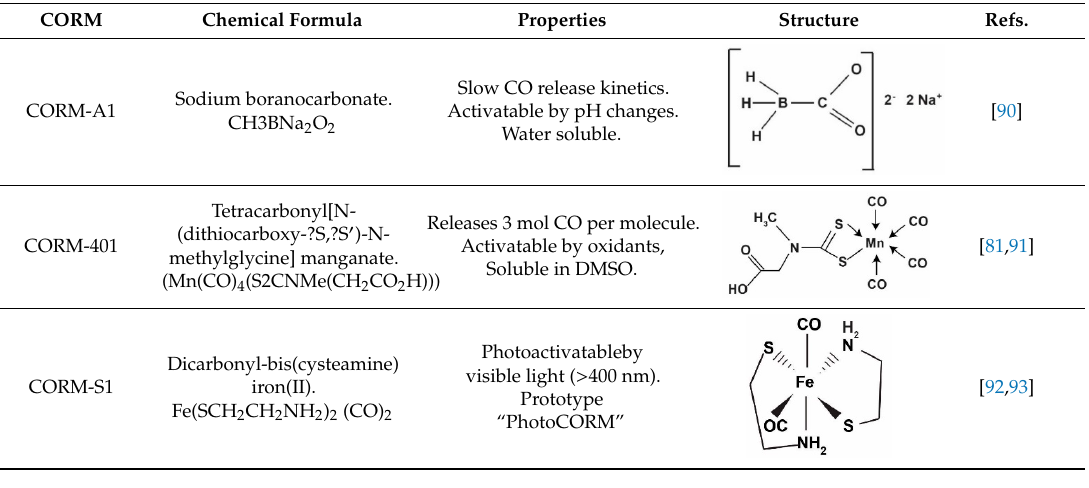
Table 2. Representative studies showing CO-dependent protection in inflammation models.